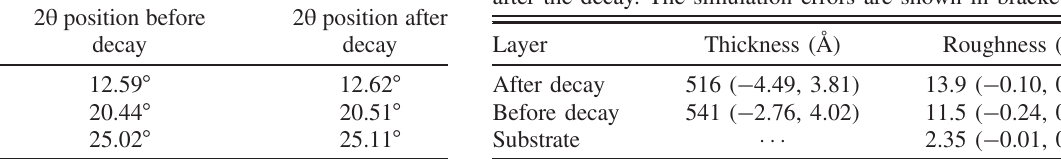
TABLE III. Simulation results to fit the XRR experimental data measured from the substrate and the photocathode before and after the decay. The simulation errors are shown in